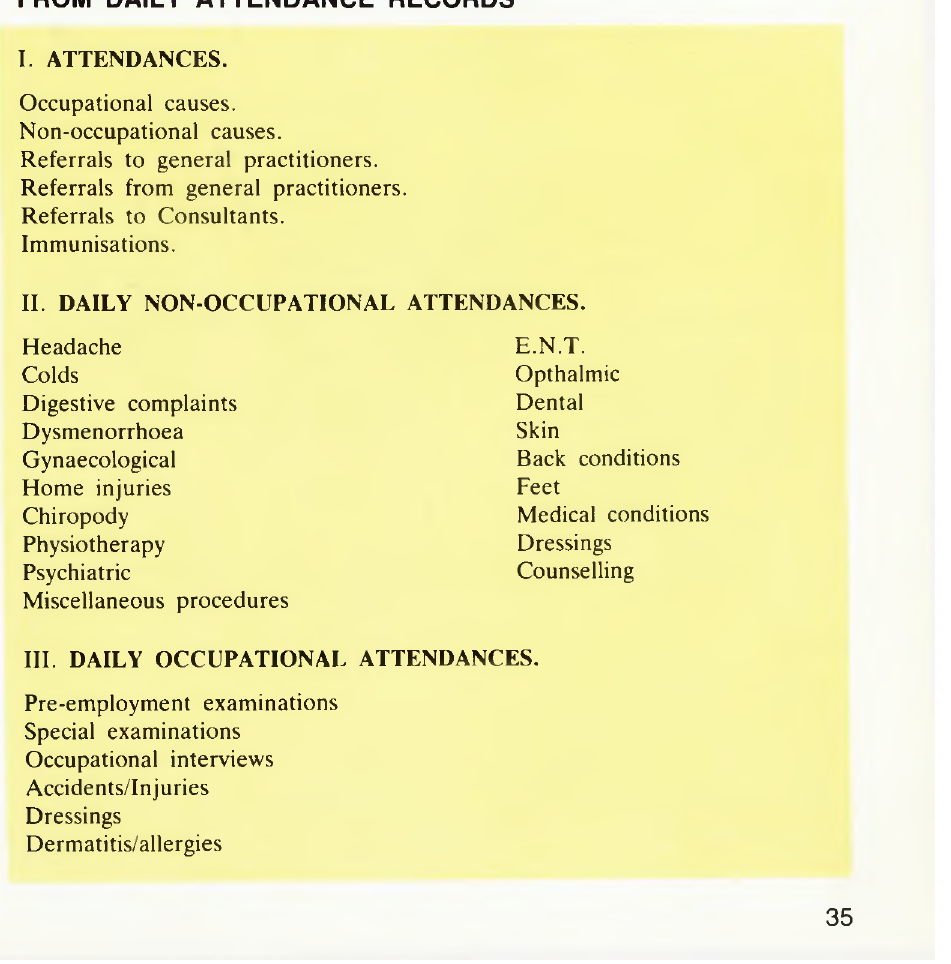
TABLE 2: EXAMPLES OF STUDIES WHICH COULD BE